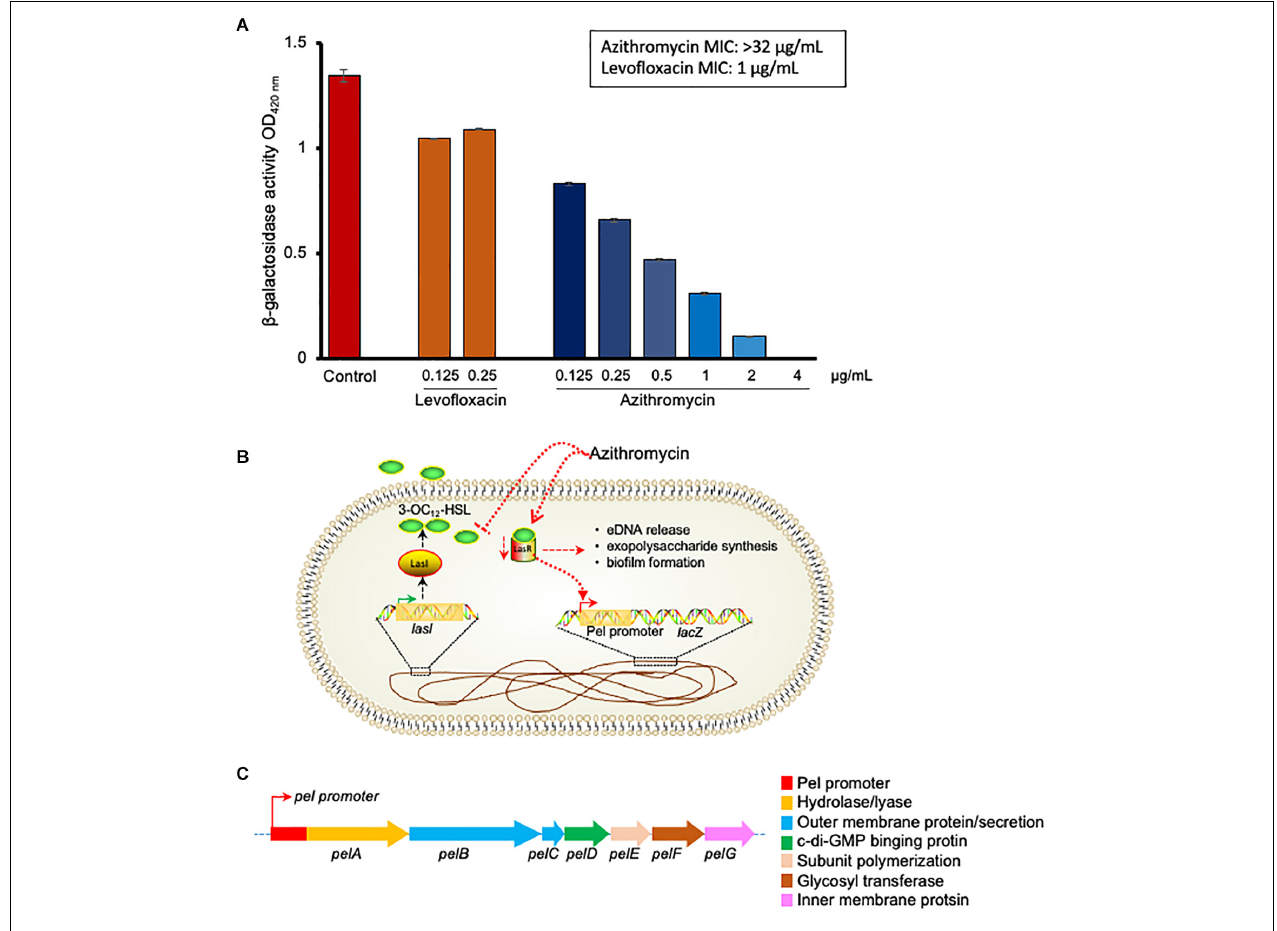
FIGURE 3 | p-galactosidase activity of P. aeruginosa G2 recombinant construct containing pel promoter-lacZ transcriptional fusion in presence of different concentration of azithromycin, levofloxacin or no-drug control (A) . The MIC of azithromycin and levofloxacin was > 32 and 1 ng/mL, respectively, against P. aeruginosa G2. Proposed mechanism of biofilm and pel genes inhibition by azithromycin (B) .Genetic structure of pel genes in P. aeruginosa (C)